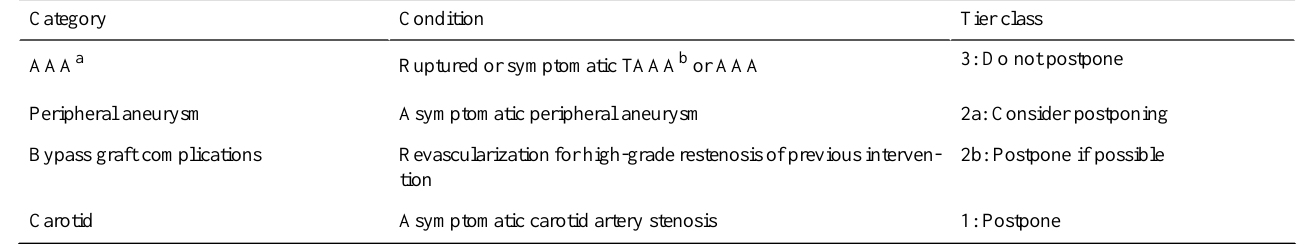
Table 4. Examples of COVID-19 guidelines for the triage of vascular surgery